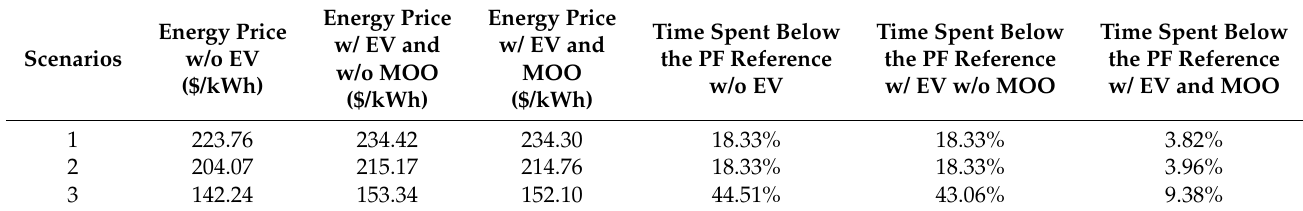
Table 5. Quantitative analysis of energy price and time spent below the power factor